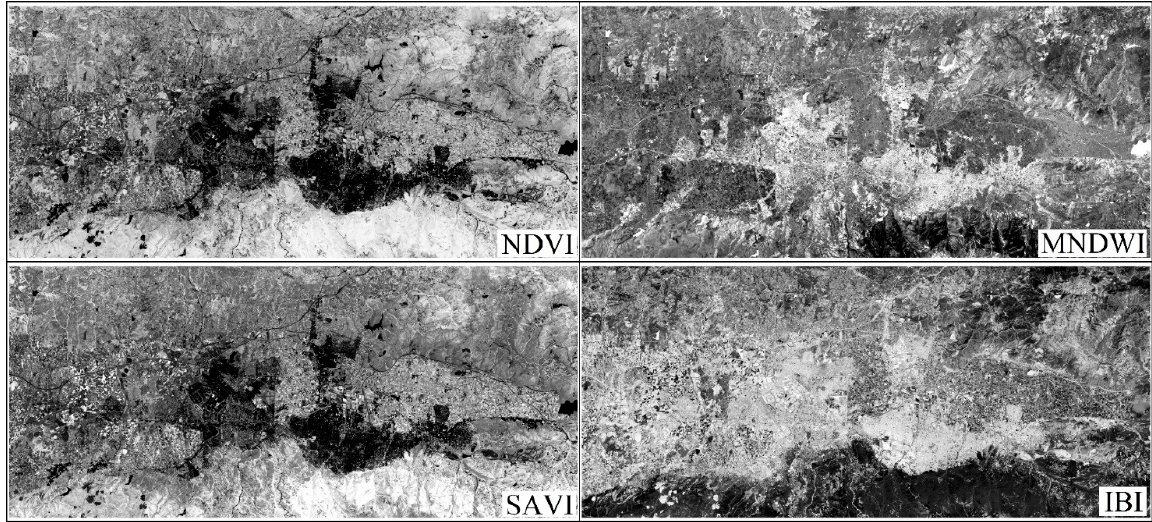
Figure 3. The obtained NDVI, SAVI, MNDWI and IBI remote sensing indices using the Landsat 8 image obtained on 1 July